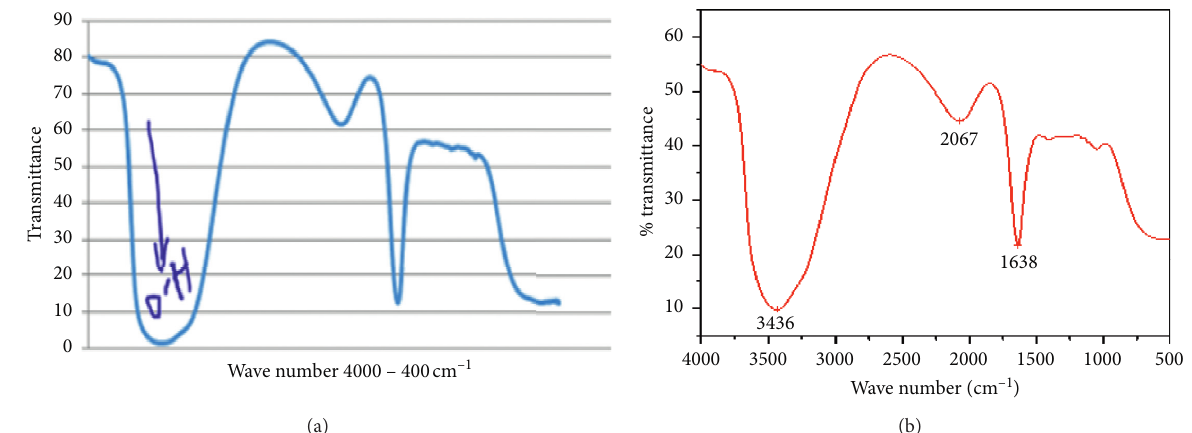
Figure 7: FTIR spectrum of the ethanol yield at acid concentration of 4% and temperature of 150 ° C and for a hydrolysis of 90 minutes. (a) Chiquere variety; (b) Gebabe variety.